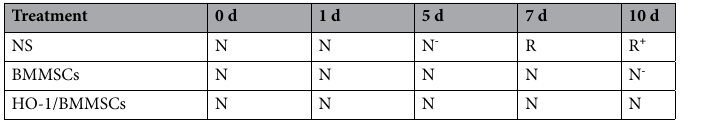
Table 1. Clinical evaluation after LT. N = No rejection, R = Rejection, R + = Aggravation of rejection, N − in the NS group = 15 rats showed some signs of rejection. N − in the BMMSC group = 11 rats showed some signs of rejection.